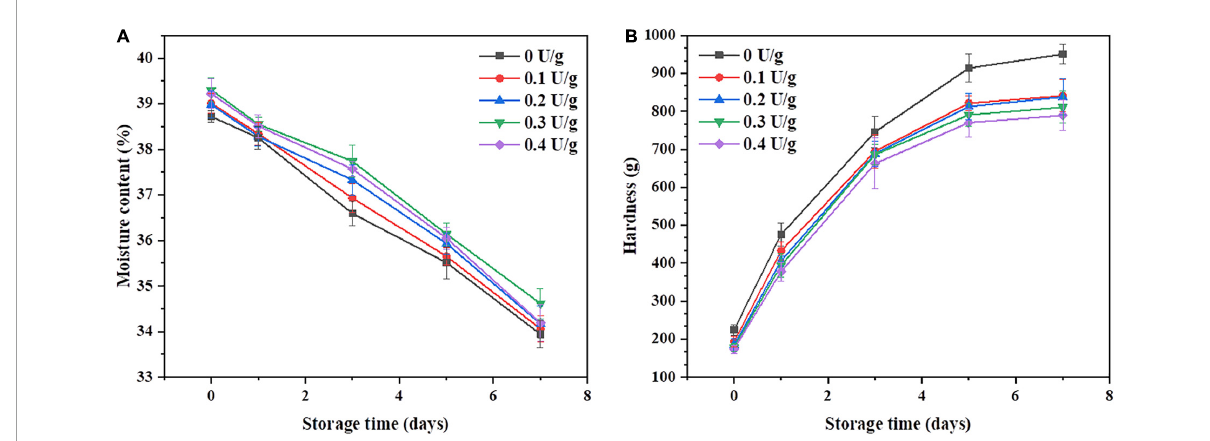
FIGURE2 Moisture content (A) and hardness (B) of the bread with or without CGTase after storage at 20 ◦ C for 7 days.